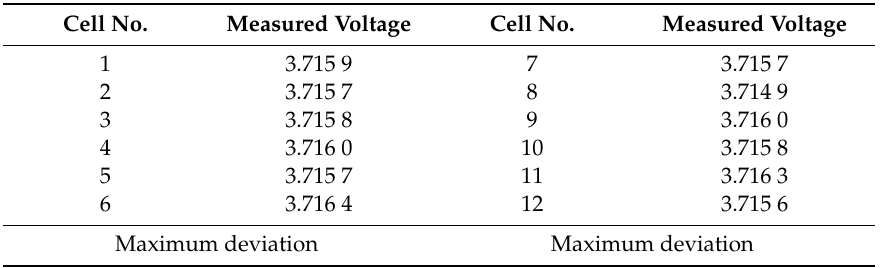
Figure 17. Comparison of the 0.2 C discharge outcomes: ( a ) Battery only, and ( b ) with the BMS.